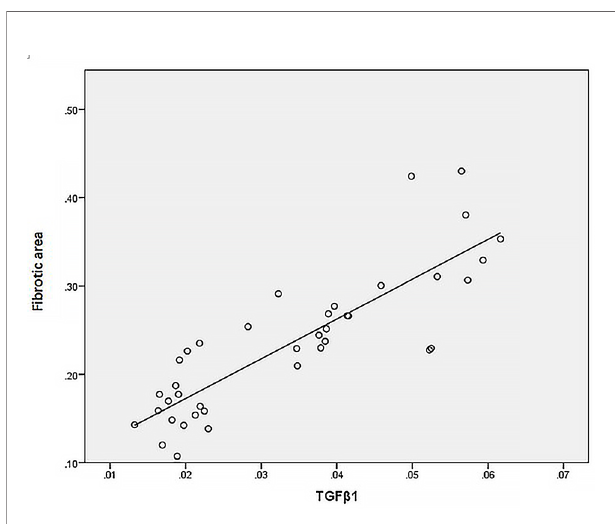
FIGURE 9 | TGF- b 1 was positively correlated with fi brotic area (n=40, r=0.853,